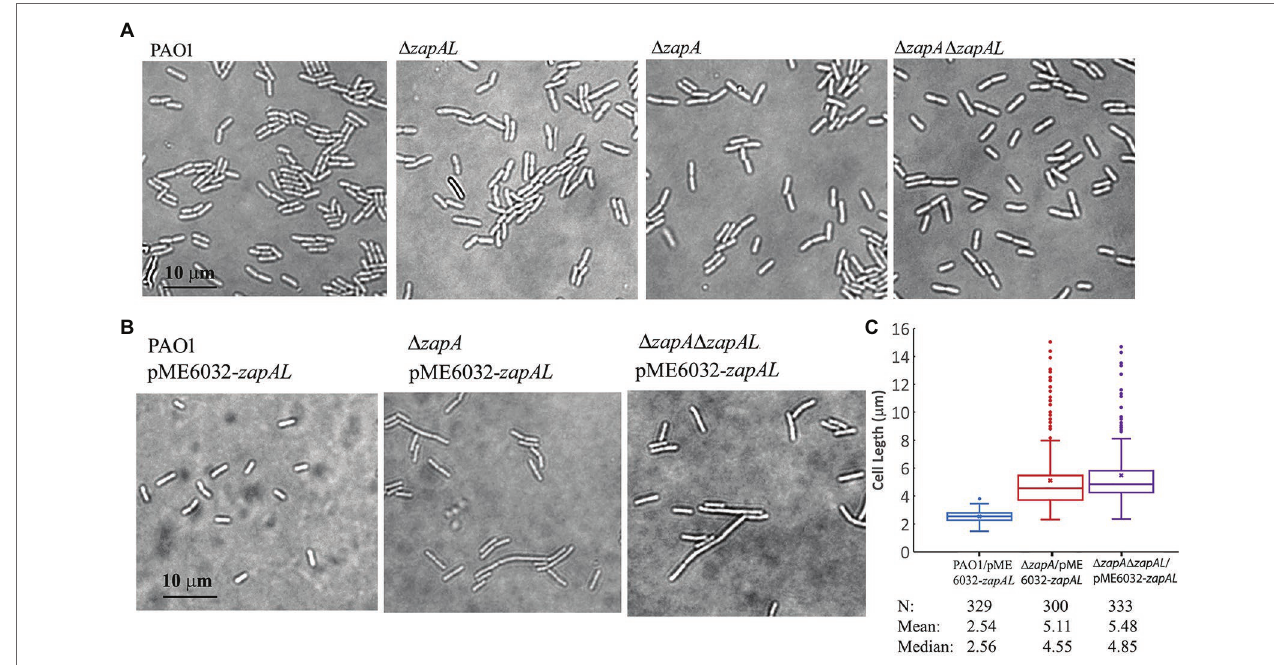
FIGURE 5 | Morphology of strains of zapAL deletion or overexpression. (A) Representative images of strains of wildtype (PAO1), Δ zapAL , Δ zapA , and Δ zapA Δ zapAL show little change of cell morphology, indicating that both zapAL and zapA are not essential genes. (B) Overexpression of ZapAL has little effect on the morphology of wildtype PAO1, while it causes slight cell elongation in the strains of Δ zapA and Δ zapA Δ zapAL . (C) Box plot illustrating the comparison of bacterial lengths when ZapAL is overexpressed in the strains of PAO1, Δ zapA and Δ zapAL Δ zapA . The boxes in the box plot show the median and the first and third quartiles. The length of the upper whisker is the largest value that is no greater than the third quartile plus 1.5 times the interquartile range. The number of bacterial cells, mean and median values of bacterial length ( μ m) are presented at the bottom of the graph. The average length of zapA -deleted cells is approximately twice that of wildtype cells after overexpression of ZapAL and part of them exceed 10 μ